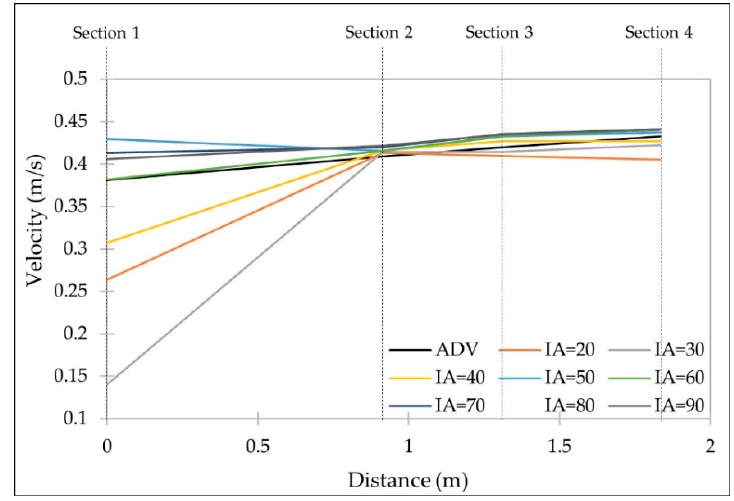
Figure 7. Measured Velocities obtained using LSPIV and ADV at Line-D (see Figure 5).